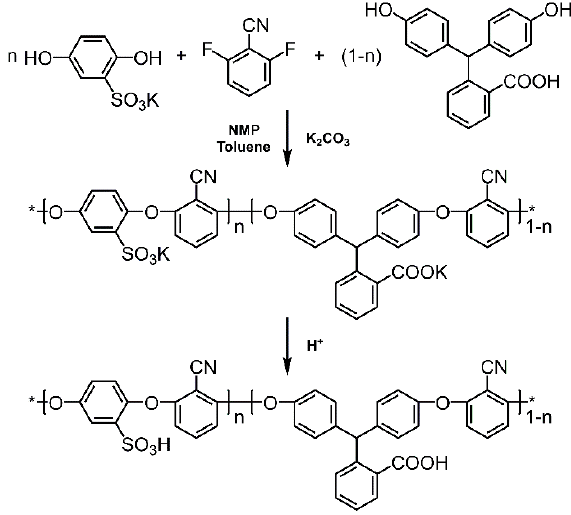
Scheme 1. Synthetic route for SCPEN copolymers.